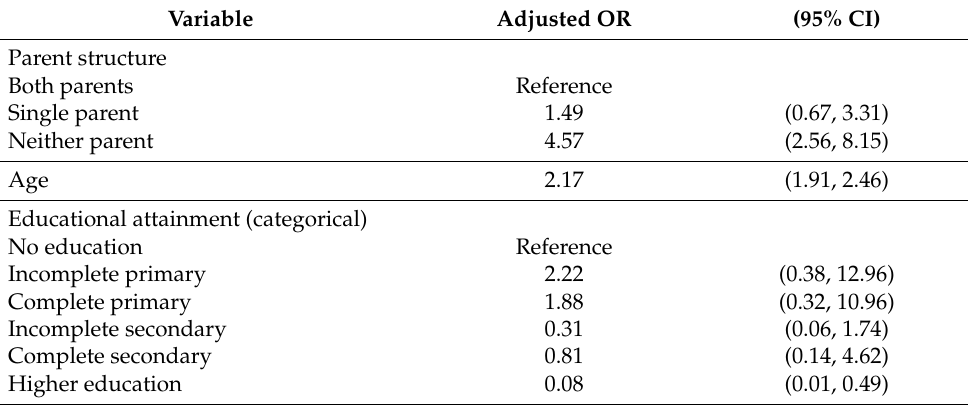
Table 3. Factors associated with teenage